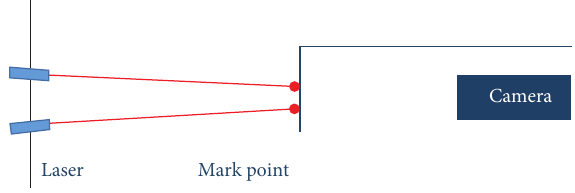
Figure 1: Structure diagram of the laser vision